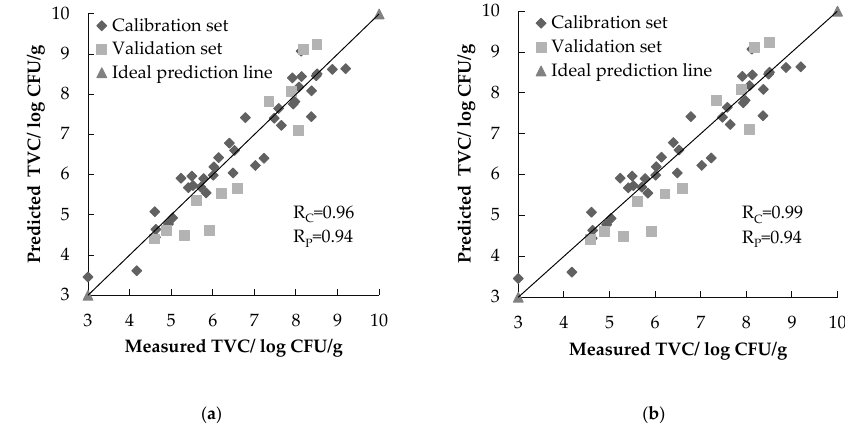
Figure 5. Results of optimum PLSR model and SVR model between the predicted total viable bacteria count (TVC) value and the reference measurement values: ( a ) Result of the best PLSR model; ( b ) Result of the best SVR model. SVR: support vector machine